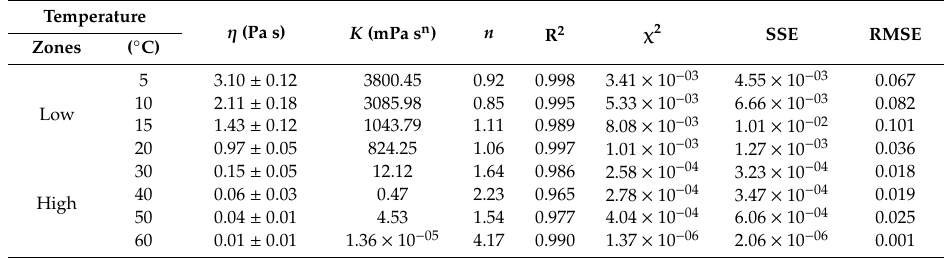
Table3. Rheologicalparametersbythepowerlawmodelforoleoresinextractedatdi ff erenttemperatures by SC-CO 2 from the microalga Haematococcus pluvialis